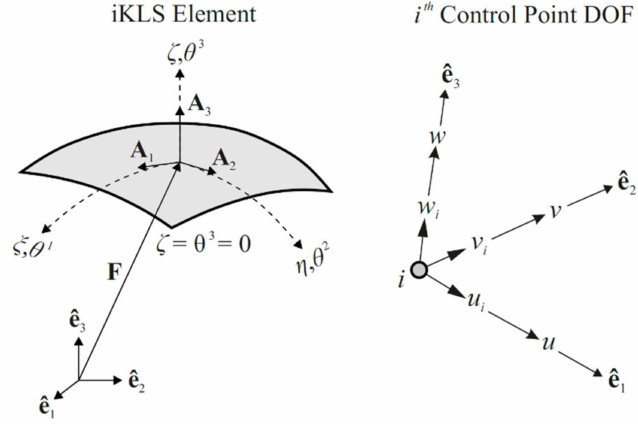
Figure 4. The isogeometric Kirchho ff –Love inverse-shell (iKLS) element and displacement DOF of i th control